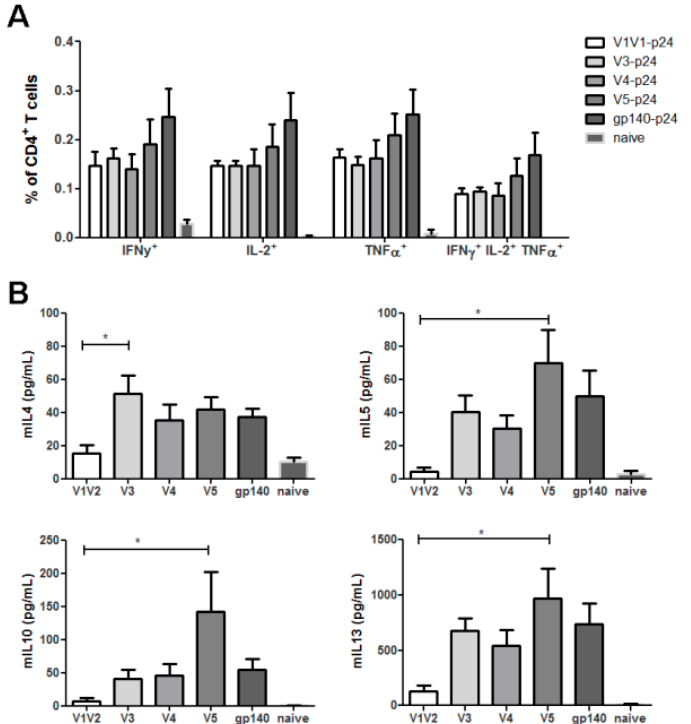
Figure 8. Cellular immune responses to the truncated variants of Env. Balb/c mice were vaccinated twice with the plasmids encoding the truncated Env-variants V1V2, V3, V4, V5, and the parental gp140 construct. Env-specific CD4 + T-cell responses were analyzed two weeks after the immunization. Intracellular cytokine staining was used for the detection of the typical TH1 cytokines and the percentages of IFN- γ , TNF- α and IL-2 producing CD4 + T-cells as well as polyfunctional triple positive cells are depicted in ( A ). In contrast, the analysis of TH2 cytokines was performed by a cytokine specific ELISA ( B ). In each graph, the bars represent the mean values with SEM of 4–6 mice (* p < 0.05, one-way ANOVA with Tukey’s